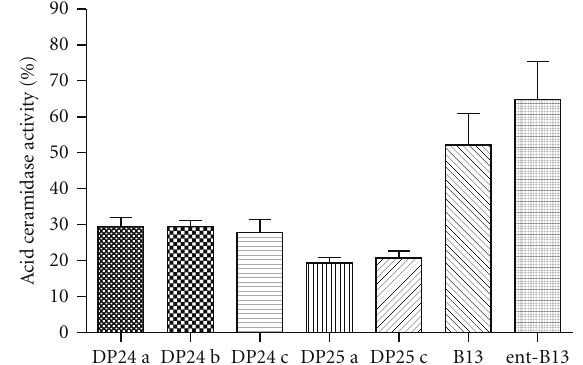
Figure 6: IC 50 curve for DP24a. The IC 50 value was calculated as being 1.287 μ M. Each concentration was measured in